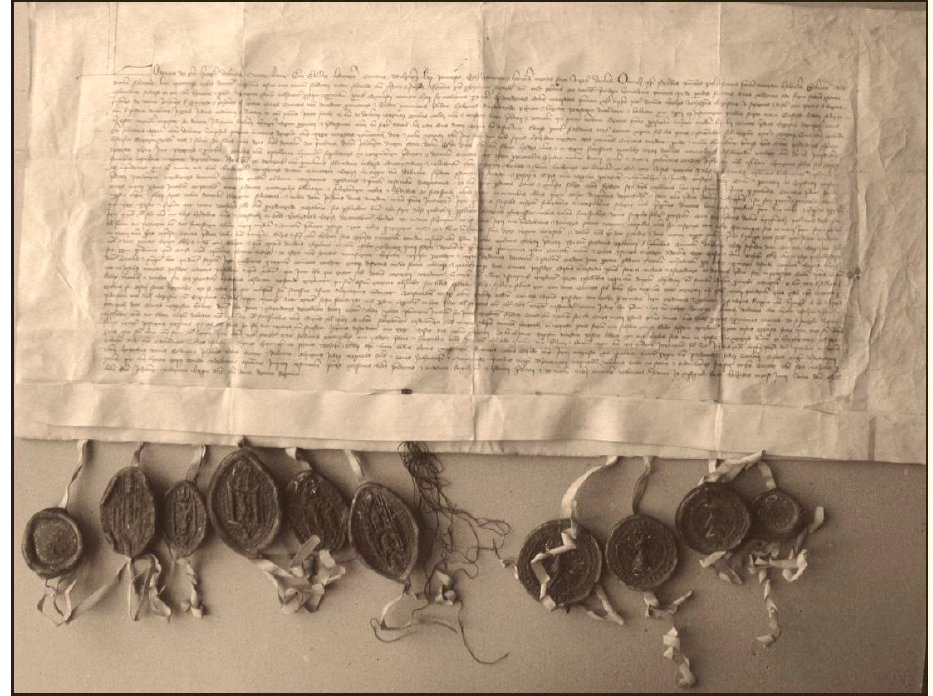
Figure 1. The diploma issued by Louis the Great (1342–1382) and certain chief dignitaries, strengthening the king’s authority over Raguza/Dubrovnik and, together with the envoys of the city, determining the city’s obligations and privileges. The king gained authority over Raguza, according to the 18 February 1358 Treaty of Zadar. Visegrád, 27 May 1358. Državni arhiv Dubrovnik, 7.